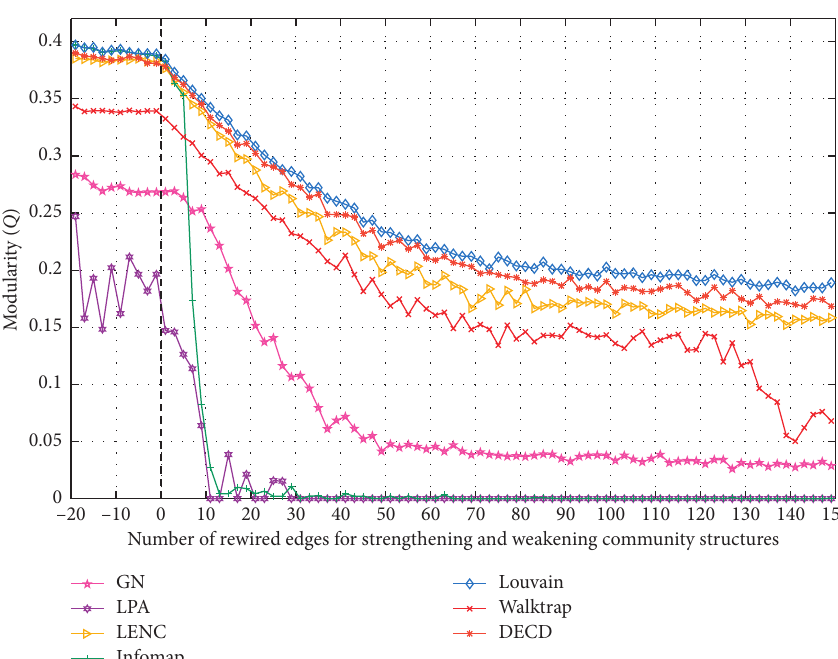
Figure 7: The average optimal value of Q obtained by typical community detection algorithms on a set of benchmarks with gradually modified community intensity, which are generated based on the anatomical connection network of macaque cortex. Each data point is obtained based on averaging 10 independent runs of each algorithm on each benchmark. The negative and positive values of the abscissa represent the number of rewired edges when the community structure is strengthened and weakened, respectively.